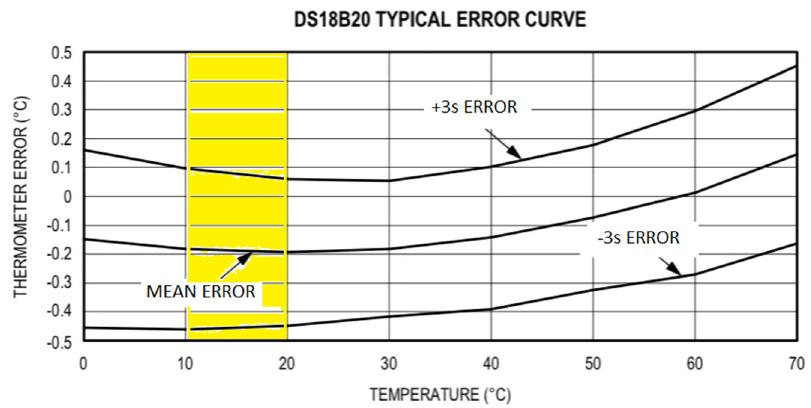
Figure 17. Arduino assembly with Shiel SD card and the final device adapted to field work.